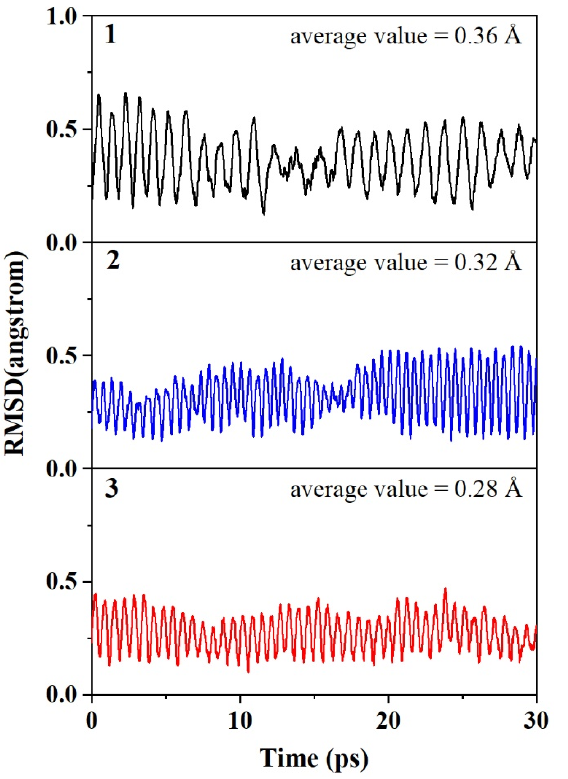
Figure 3. Calculated root-mean-square deviations (RMSDs) of GM clusters 1 – 3 during the Born- Oppenheimer molecular dynamics (BOMD) simulations at 298 K.